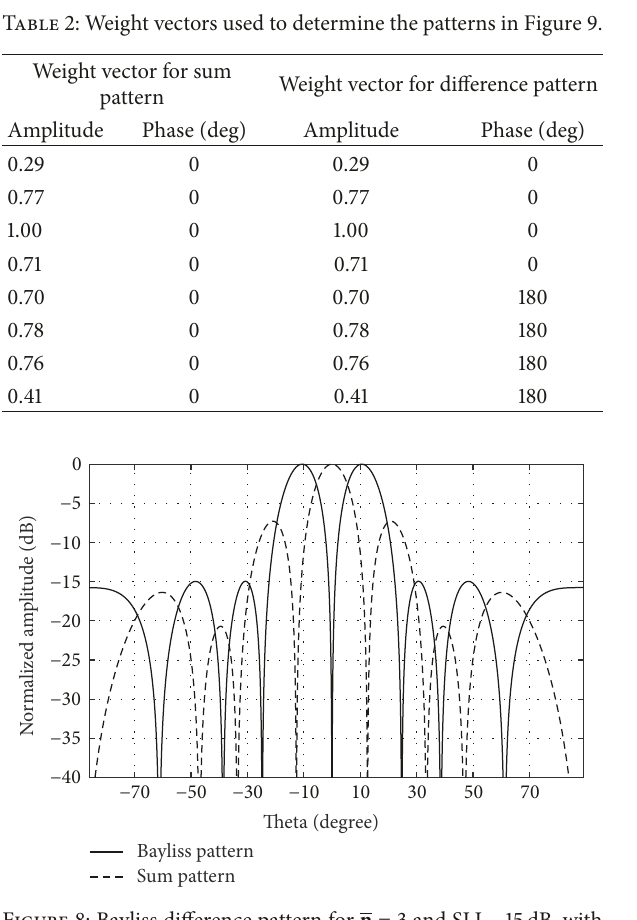
Figure 8: Bayliss difference pattern for n = 3 and SLL − 15dB, with corresponding sum pattern.